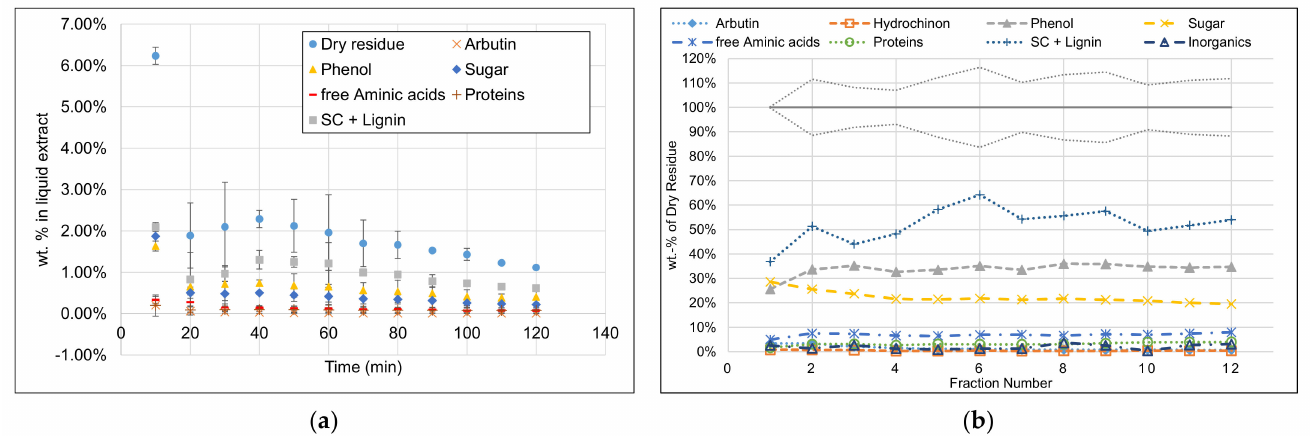
Figure 4. ( a ) Extraction profile for components and component groups and ( b ) composition of dry residue with fidelity of mass balance shown as dotted line around 100%.